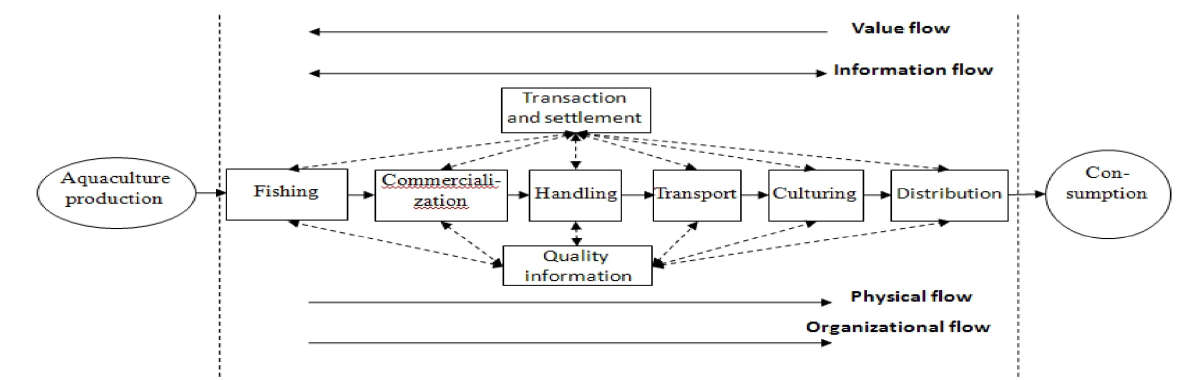
Figure 1. Modern supply chain of freshwater live fish